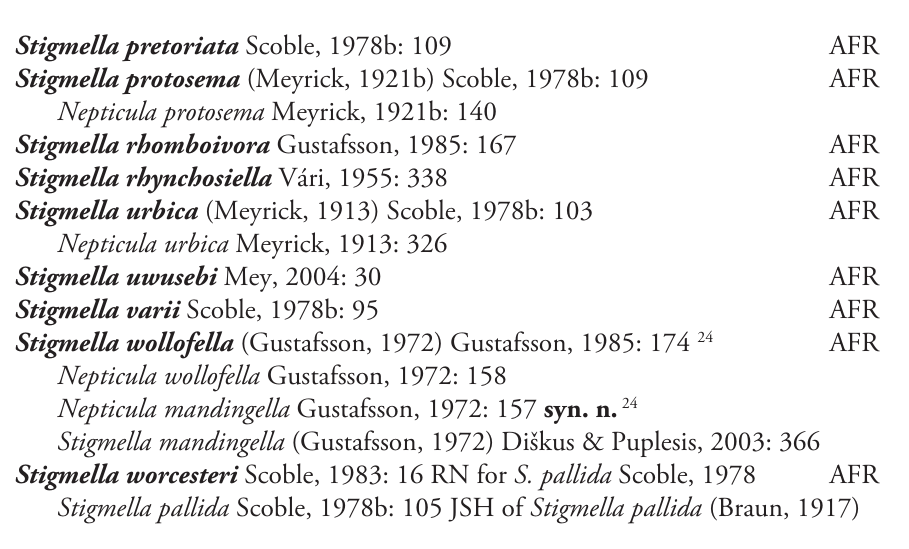
Australian species